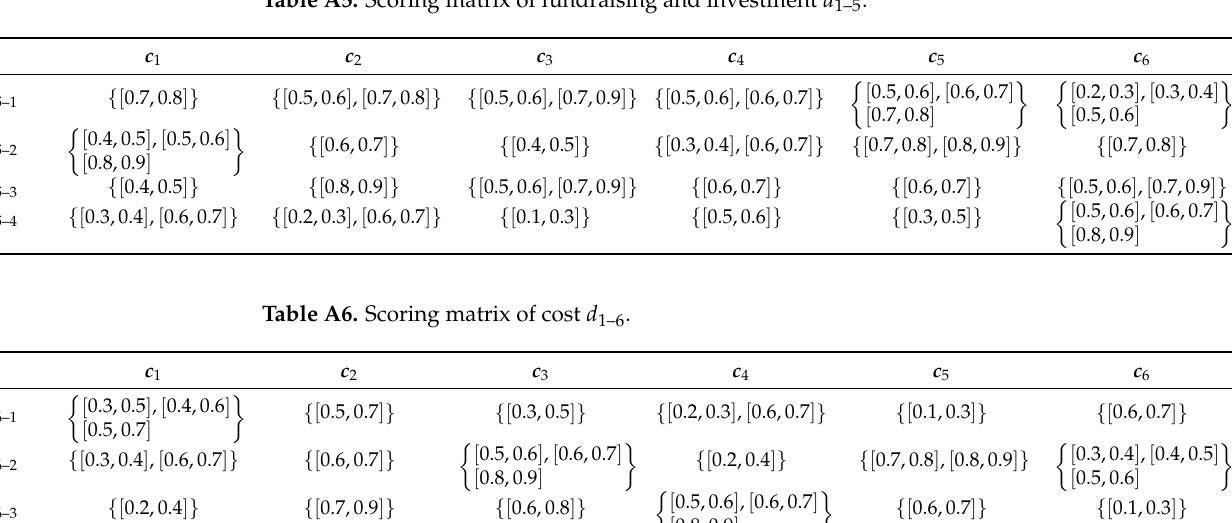
Table A5. Scoring matrix of fundraising and investment d 1–5 .